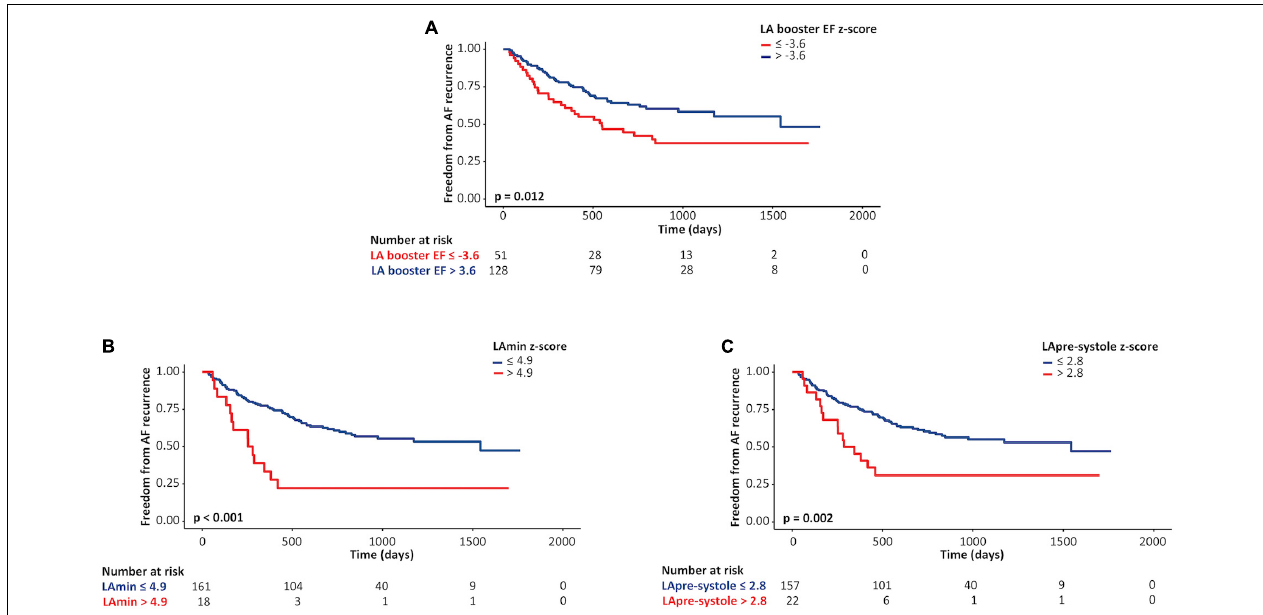
FIGURE 3 | Kaplan-Meier curves for left atrial (LA) parameters as predictors of AF recurrence. Unadjusted Kaplan-Meier curves describing associations between lower vs. higher Z-scores of LA booster ejection fraction (EF; A ), minimum LA volume (LAmin; B ), and pre-systole LA volume (LApre-systole; C ) values and freedom from atrial fibrillation recurrence following pulmonary vein ablation.